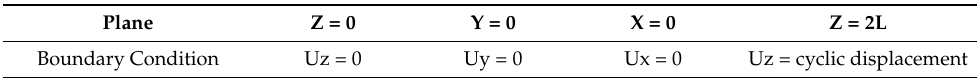
Figure 3. A discretized model of the repaired aluminum plate containing a surface crack. Table 4. The boundary conditions applied to the